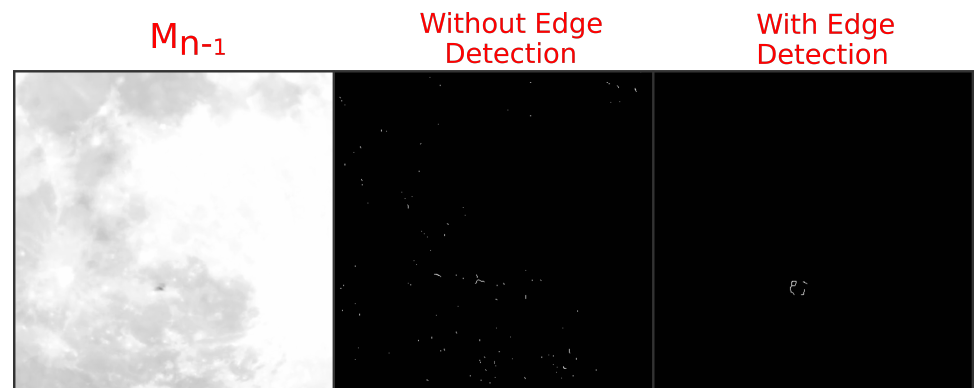
Figure 4. Performing edge detection is necessary for object detection on a complicated background. The image of the bird silhouette in front of the moon in the original image has been processed through the UnCanny detector without and with the Sobel edge detection steps. Excluding edge detection from the process produces an image with many errors generated by slight differences in the background between input images M n − 1 and M n